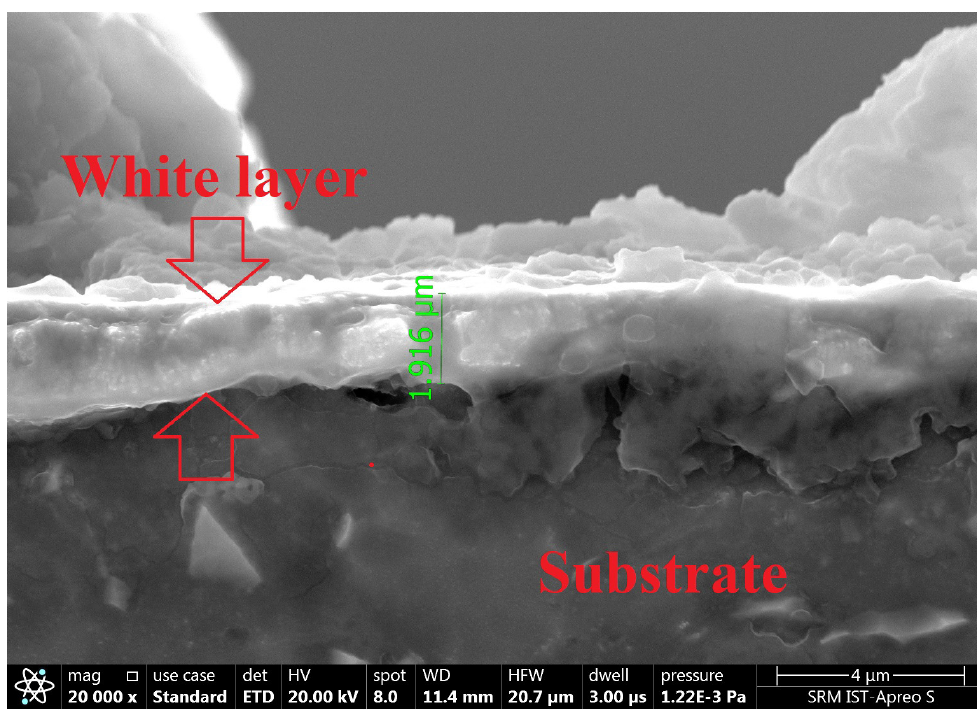
Figure 7. White layer.